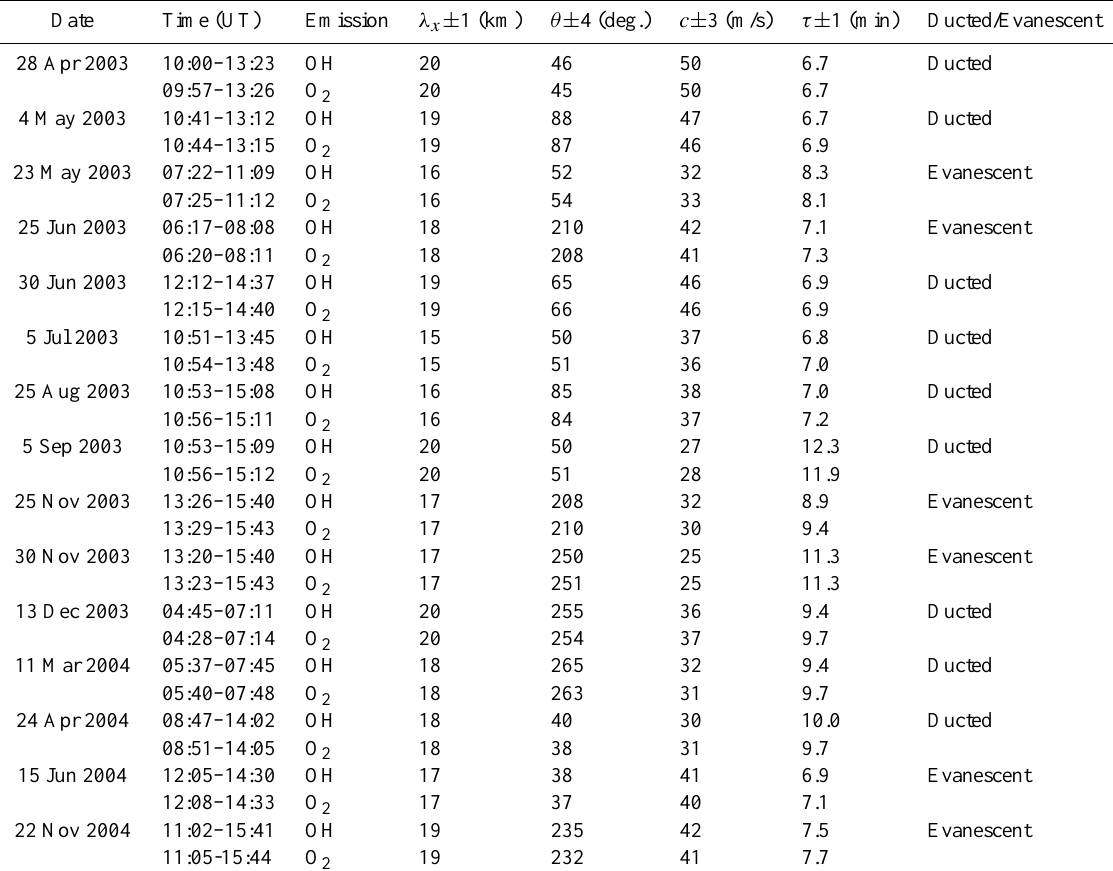
Table 1. Data summary of horizontal wave parameters, as determined from the image data, including date of occurrence, duration, horizontal wavelength ( λ x ), direction of propagation ( θ ), phase speed ( c ), observed period ( τ ) and ducted or evanescent status for the 80–100km altitude